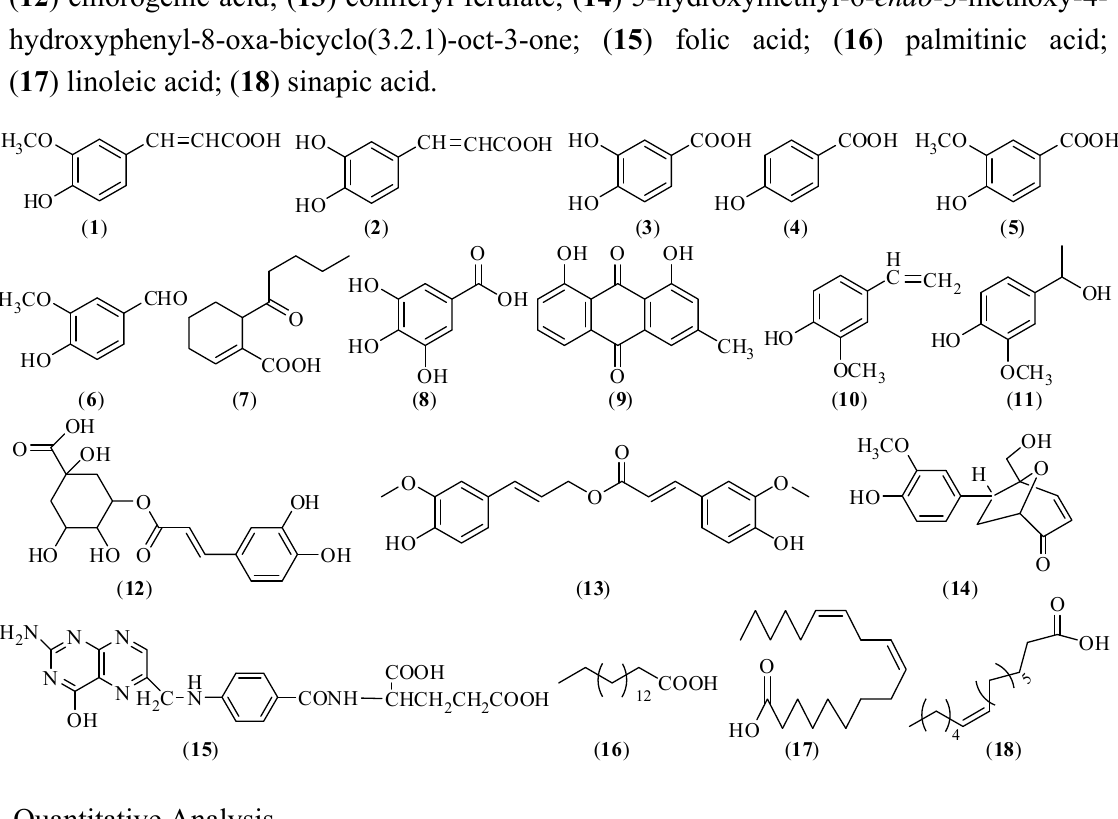
Figure 1. Chemical structures of the identified phenols and organic acids in